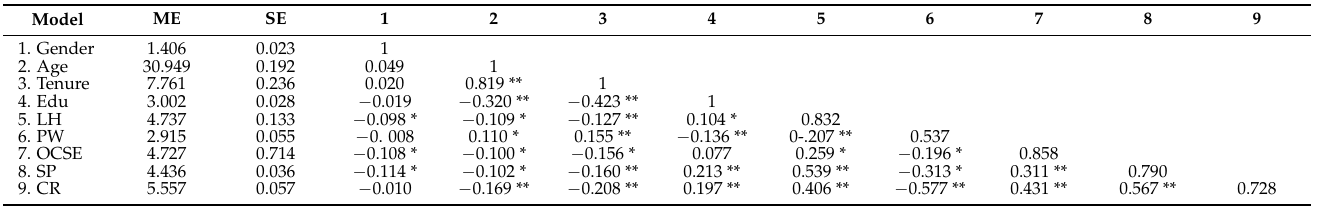
Table 2. Descriptive statistical, correlation coefficient, and reliability coefficient among variances (N =